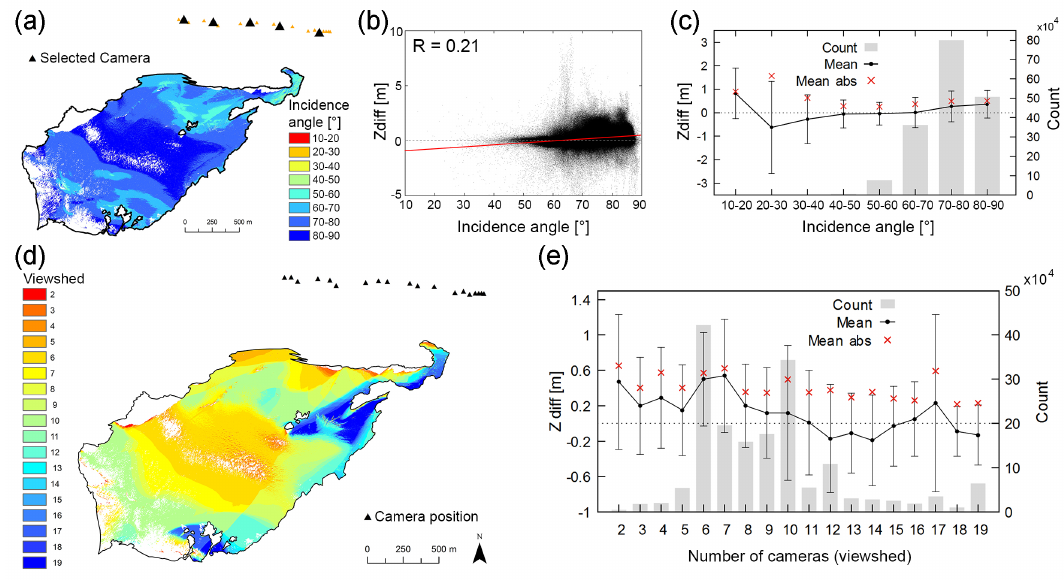
Figure 9. Mean incidence angles between five representative cameras positions and vectors normal to the surface and viewshed analysis: (a) map of the mean incidence angle calculated for five representative camera positions; (b) the scatter plot of the elevation difference and the mean incidence angle for the five representative camera positions; (c) mean with 1 standard deviation error bars in y and mean of the absolute value of elevation differences for the mean incidence angle intervals calculated for the five selected representative camera positions, in 10 ◦ bins; (d) map of the analysis using viewshed number of cameras able to see each pixel derived from all camera positions; (e) mean with 1 standard deviation error bars and mean of the absolute value of elevation differences for the viewshed reconstructed area